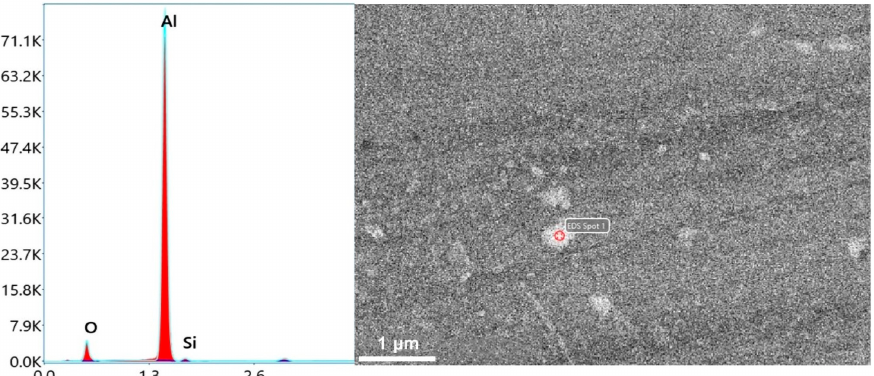
Figure 12. ( a ) TEM and ( b ) HRTEM images of modified Al–20Si alloy.